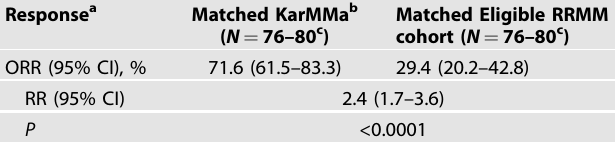
Table 3. Overall response rates adjusted for matching.